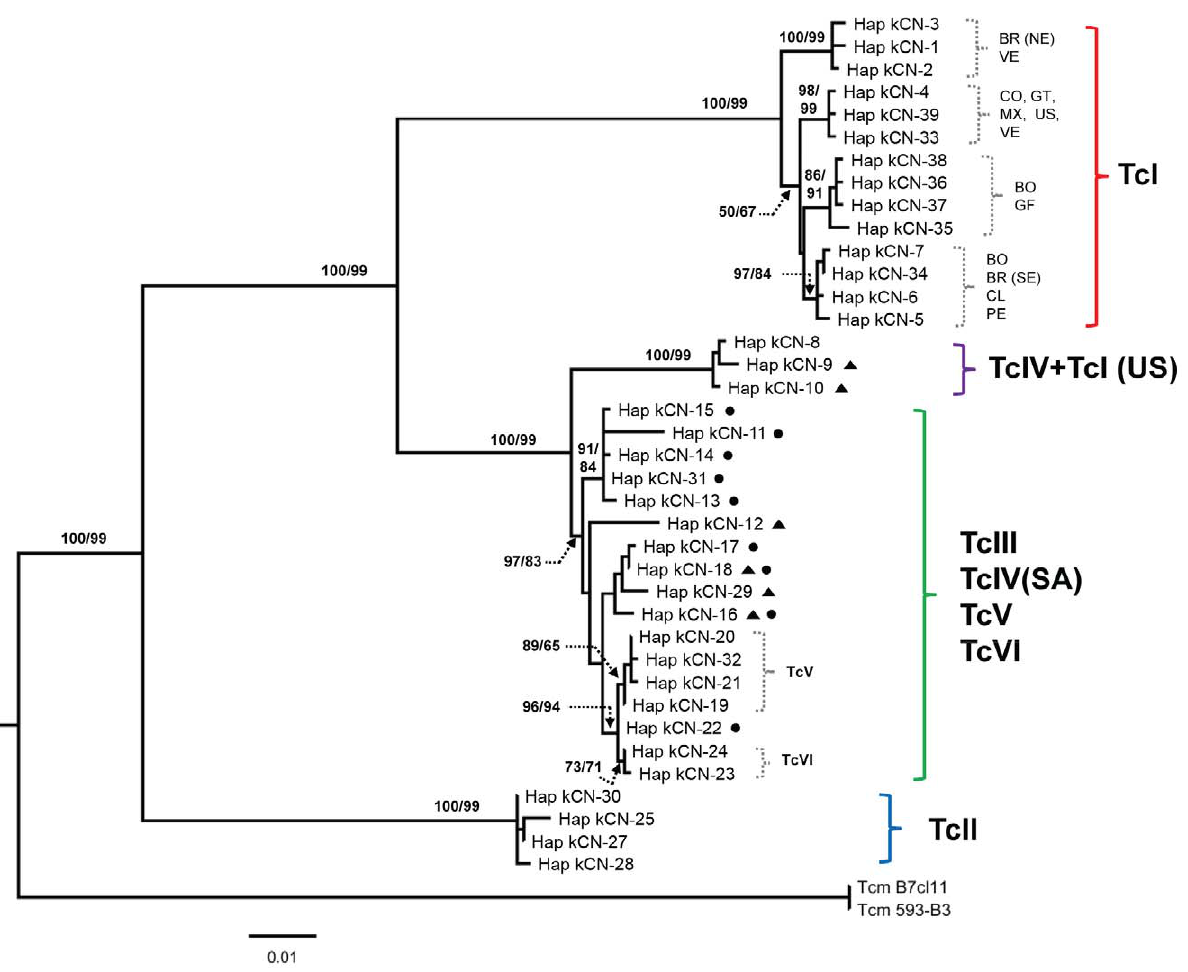
Figure 2. Maximum likelihood tree of COII-ND1 sequences (unique haplotypes). Clades and subclades are indicated according to corresponding major T. cruzi lineage (see text). Black circles indicate TcIII haplotypes and black triangles indicate TcIV haplotypes, clearly showing paraphyly of TcIV and TcIII sequences and sharing of identical haplotypes between subsets of TcIII and TcIV samples. Where clear geographic associations were evident these are indicated using standard two letter country codes; TcIV(SA) are TcIV samples from South America. Bootstrap support values for branches (if . 50%) are shown and were calculated for the equivalent nodes of the bootstrap consensus NJ/MP trees (1000 replicates). Scale units are substitutions/site. doi:10.1371/journal.pntd.0001363.g002 molecular clock in the Bayesian analysis of mutation rate and divergence times for nodes in the GPI tree. For COII - ND1 sequences, rooted using T. cruzi marinkellei , the molecular clock was rejected for the ML tree (LRT p =0.032; Table 2). However, for 46/98 (46.9%) of the topologies tested the molecular clock was not rejected (p . 0.05) and none of these topologies gave likelihood scores significantly worse than the ML tree (SH tests, p . 0.05) Table 2. Molecular clock likelihood ratio tests.